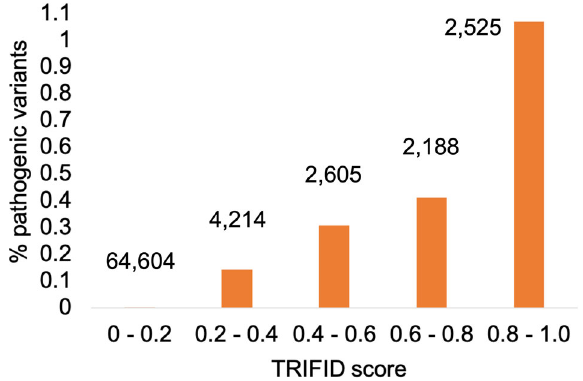
Fig. 8 Validated pathogenic variants in alternative exons binned by TRIFID score. APPRIS alternative exons from the human reference set were binned by the TRIFID score of the best-scoring transcript in which they are annotated. For each set of exons in each bin, we show the percentage of exons that are annotated with validated pathogenic variants. The 51 validated pathogenic variants tend to fall in the highest scoring exons. Differences between the bins were huge, and signi fi cant despite the low numbers of validated pathogenic variants, Fisher exact tests showed that the percentage of pathogenic variants with best TRIFID scores exceed- ing 0.8 was signi fi cantly higher than those in all other bins (two tailed Fisher ’ s Exact test p = 0.0111 against the 0.6 – 0.8 bin, p = 0.001 against the 0.4 – 0.6 bin, and p < 0.00001 for the other two bins), and that the percentage of pathogenic variants among exons with TRIFID scores below 0.2 was signi fi cantly lower than all other bins (two tailed Fisher ’ s Exact test p < 0.00001 for all four